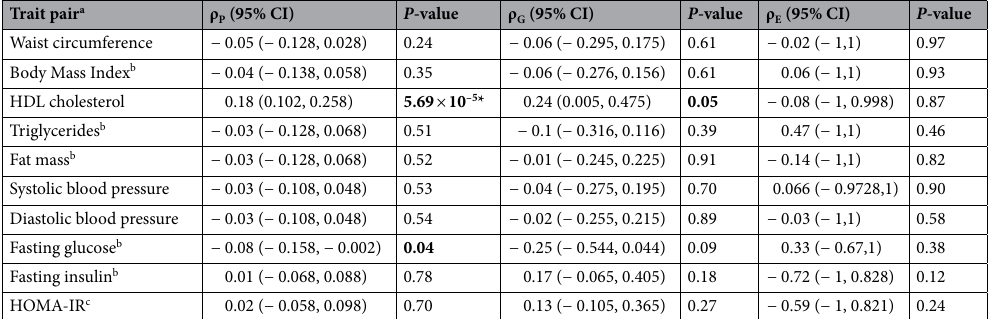
Table 2. Phenotypic (ρ P ), genetic (ρ G ) and environmental (ρ E ) correlations between lycopene and the cardiometabolic risk traits. HDL cholesterol, high-density lipoprotein cholesterol, HOMA-IR the homeostasis model of assessment-insulin resistance. Asterisks indicate the p-values that remain significant after applying FDR correction. Bold values denote statistical significance at P -value ≤ 0.05. a All traits were adjusted for the covariate effects of age and sex terms. b Data were log-transformed. c Trait was transformed using inverse normal